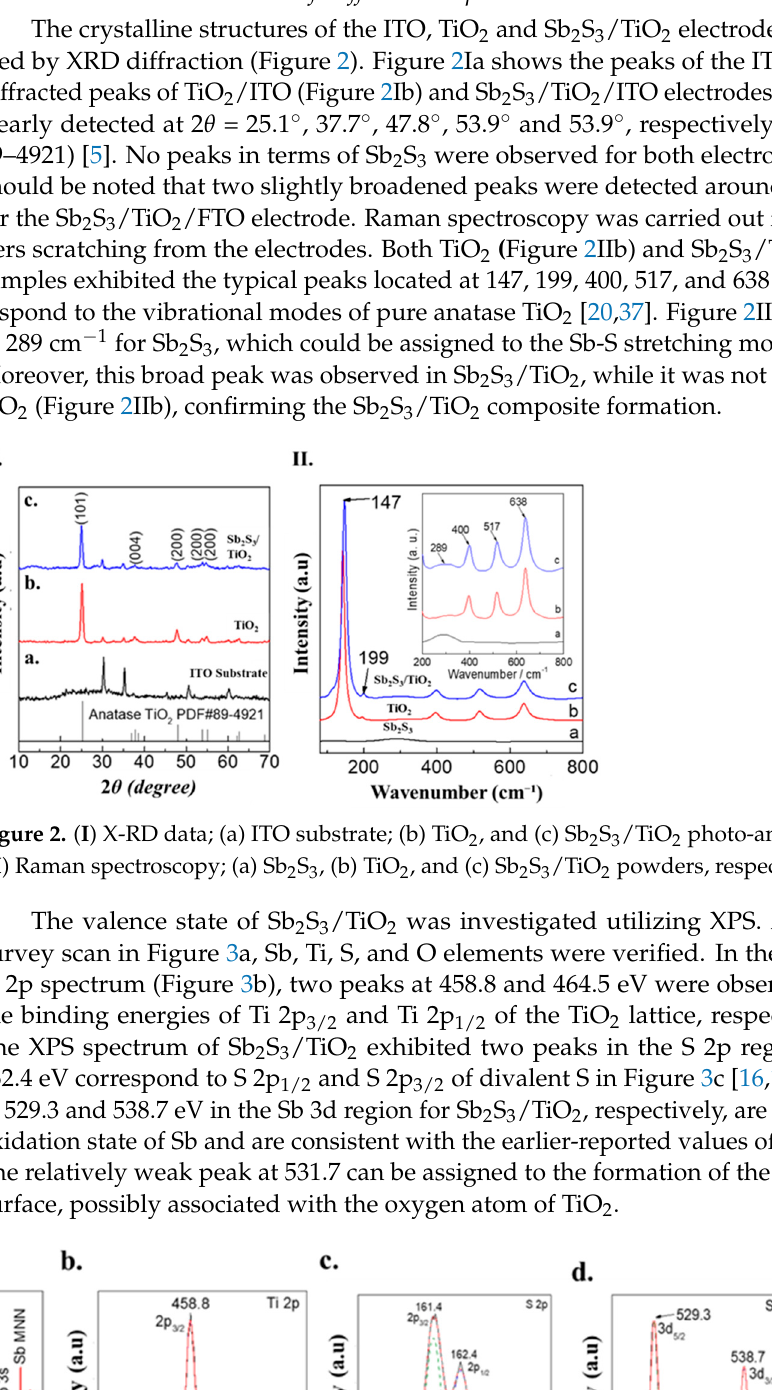
Figure 1. ( a ) UV–Vis spectral change of the Sb 2 S 3 /TiO 2 at difference time for dipping; ( b ) Plots of Absorbance vs. immersion time for Sb 2 S 3 /TiO 2 , respectively.